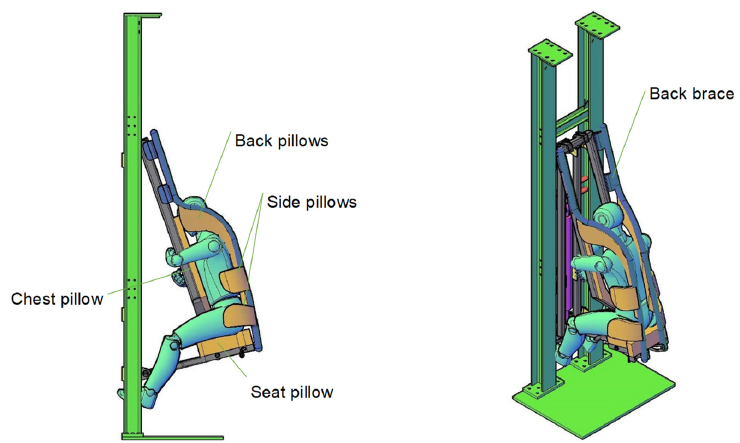
Figure 3. Chair restraint devices (pillows).